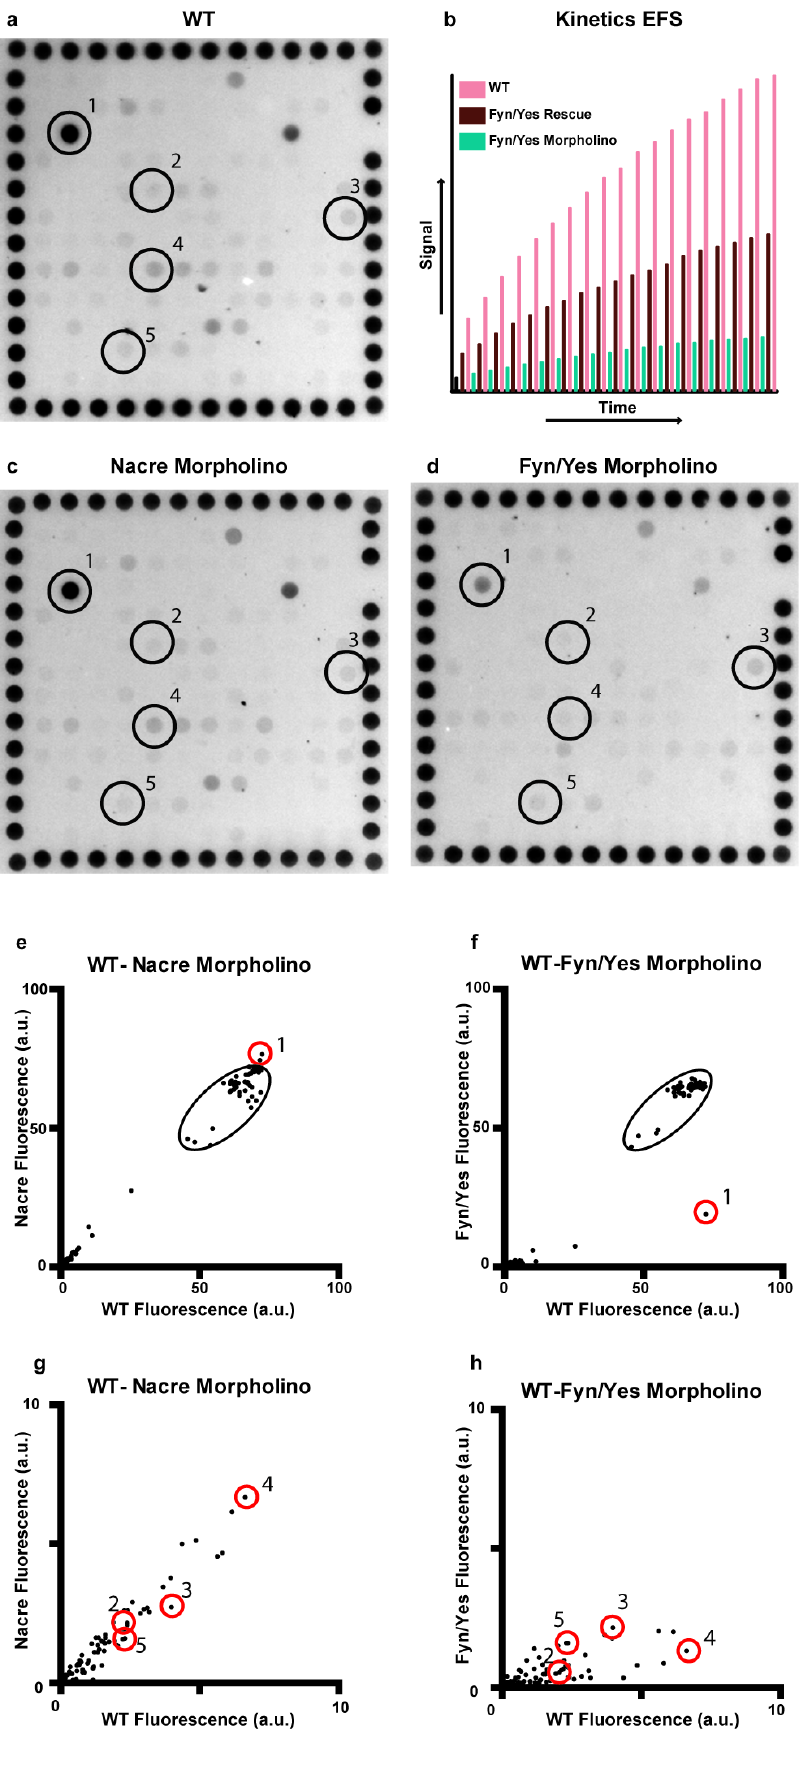
Figure 1. PTK profiles of 24 hpf zebrafish embryos. (a) Fluorescence of the panel of 144 peptides is shown after 60 min (endpoint). The fluorescently labeled control peptides at the periphery indicate the grid of 144 different peptides. (b) Kinetics of EFS peptide phosphorylation by control embryo lysate (pink), Fyn/Yes morpholino injected embryo lysate (green) and Fyn/Yes morpholino, Fyn/Yes RNA co- injected embryos (Fyn/Yes rescue, brown) is shown with a data point every three min and the fluorescence in arbitrary units. (c,d) Endpoint measurements of peptide phosphorylation by Nacre- or Fyn/Yes morpholino-injected embryo lysates. (e–h) Quantification of PTK profiles. The relative intensities of peptide phosphorylation by lysates of control, non-injected embryos were plotted against Nacre- or Fyn/Yes knock down embryos. The fluorescently labeled reference spots all lie within the indicated oval. (g,h) are a close-up of the low range of panels e and f. The five highlighted peptides are: 1,EFS; 2, FAK2; 3, LTK; 4, PAXI and 5, SYN1.